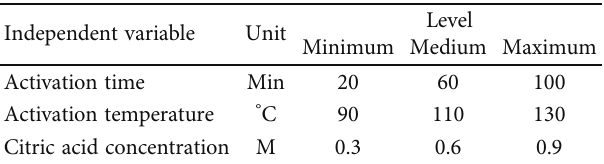
Table 1: Experimental matrix for citric acid modi fi cation of base treated neem biomass using